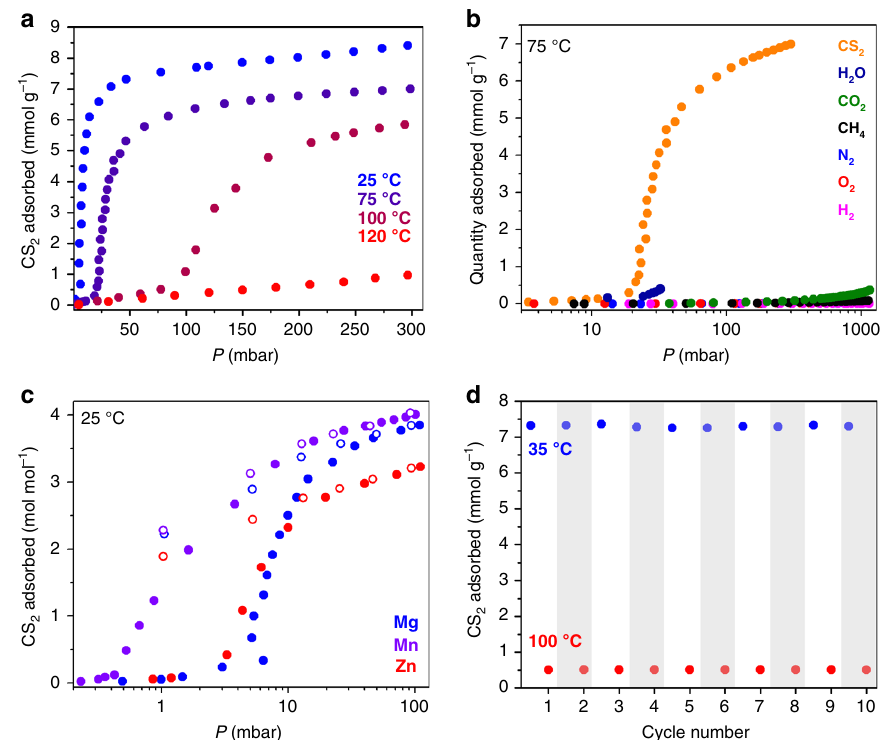
Fig. 3 CS 2 adsorption isotherms and cycling. a CS 2 adsorption isotherms for mm-2 – Mg 2 (dobpdc) at various temperatures. Adsorption capacity is in units of mmol g – 1 . b Comparison of individual adsorption isotherms of various gases at 75 °C collected for mm-2 – Mg 2 (dobpdc) with pressure plotted on a logarithmic scale and adsorption capacity in units of mmol g – 1 . c CS 2 adsorption isotherms collected for mm-2 – M 2 (dobpdc) (M = Mg, Mn, Zn) at 25 °C with pressure plotted on a logarithmic scale. Adsorption capacity is in units of mol mol – 1 . Filled circles correspond to adsorption and open circles to desorption. d Ten temperature-swing adsorption – desorption cycles for mm-2 – Mg 2 (dobpdc) under 75 mbar of CS 2 . Adsorption occurred at 35 °C (blue circles), and desorption occurred at 100 °C (red circles). Temperature was equilibrated for 30 min between measurements. White and gray